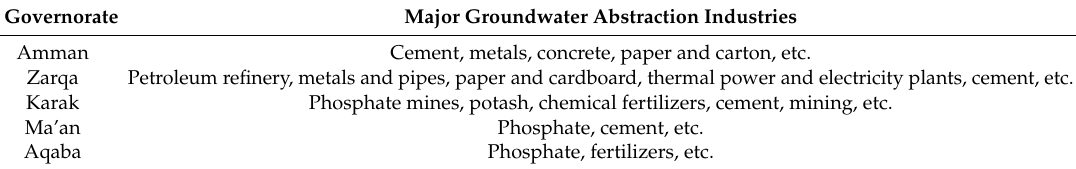
Figure 5. Percentages of total groundwater abstraction by major industries in Jordanian governorates. Table 2. Major groundwater abstraction industries in Jordan according to governorates.